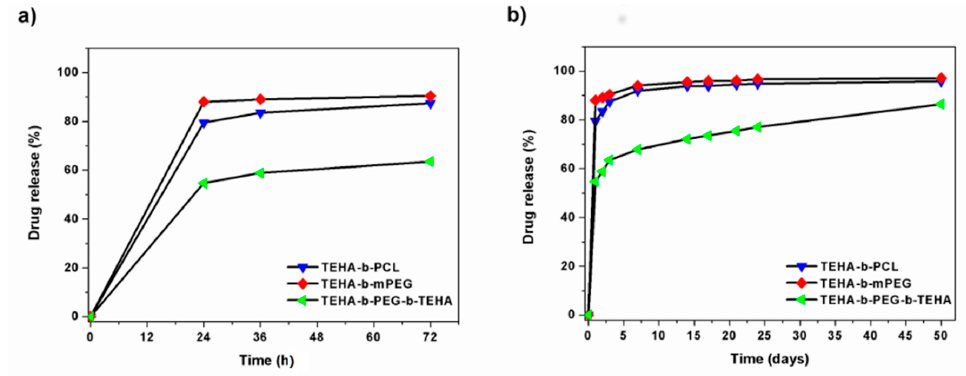
Figure 8. Percentage of release of NLX from microspheres prepared from amphiphilic TEHA-based copolymers at different time intervals: ( a ) 24, 48 and 72 h, and ( b ) 1, 2, 3, 7, 14, 17, 21, 24 and 50 days.